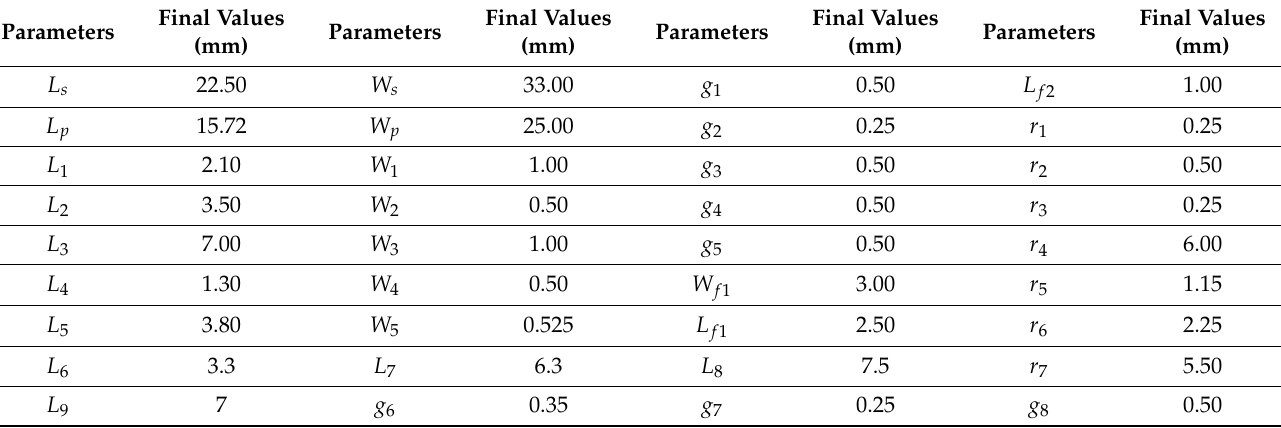
Figure 4. The reflection coefficient results with each of the SRRs and without SRR added to the button antenna. Table 2. The proposed antenna’s design parameters (mm).